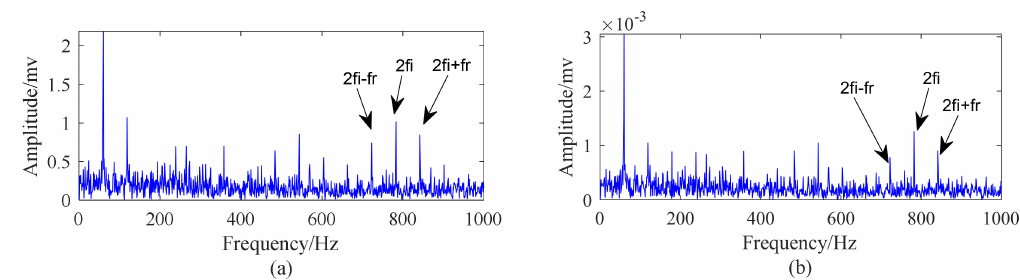
Figure 38. The diagnosis result obtained by IMF3 of the collected signal of the bearing with 3 mm inner race fault: ( a ) the squared envelope spectrum of IMF3; ( b ) the teager energy spectrum of IMF3. The FK and corresponding squared envelope spectrum are presented in Figure 39.